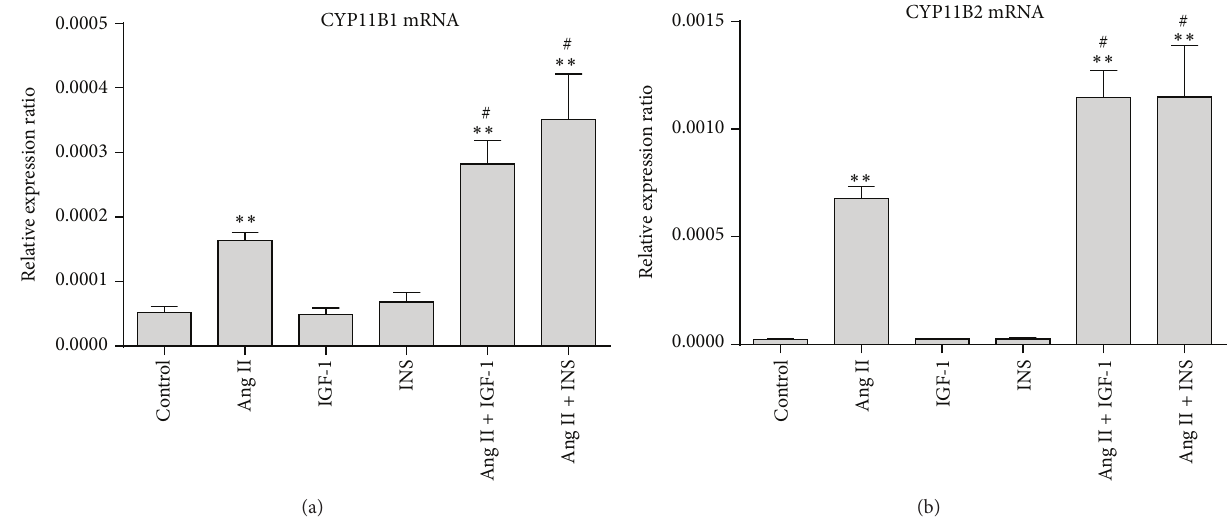
Figure 7: Effect of interaction between Ang II and insulin/IGF-1 on the expression of steroidogenic enzymes. H295R cells were treated with Ang II (100nM) and insulin (100nM)/IGF-1 (10nM), combined or alone, for 24 hours. mRNA expressions of CYP11B1 and CYP11B2 were detected. ∗∗ 𝑃 < 0.01 versus control and # 𝑃 < 0.05 versus Ang